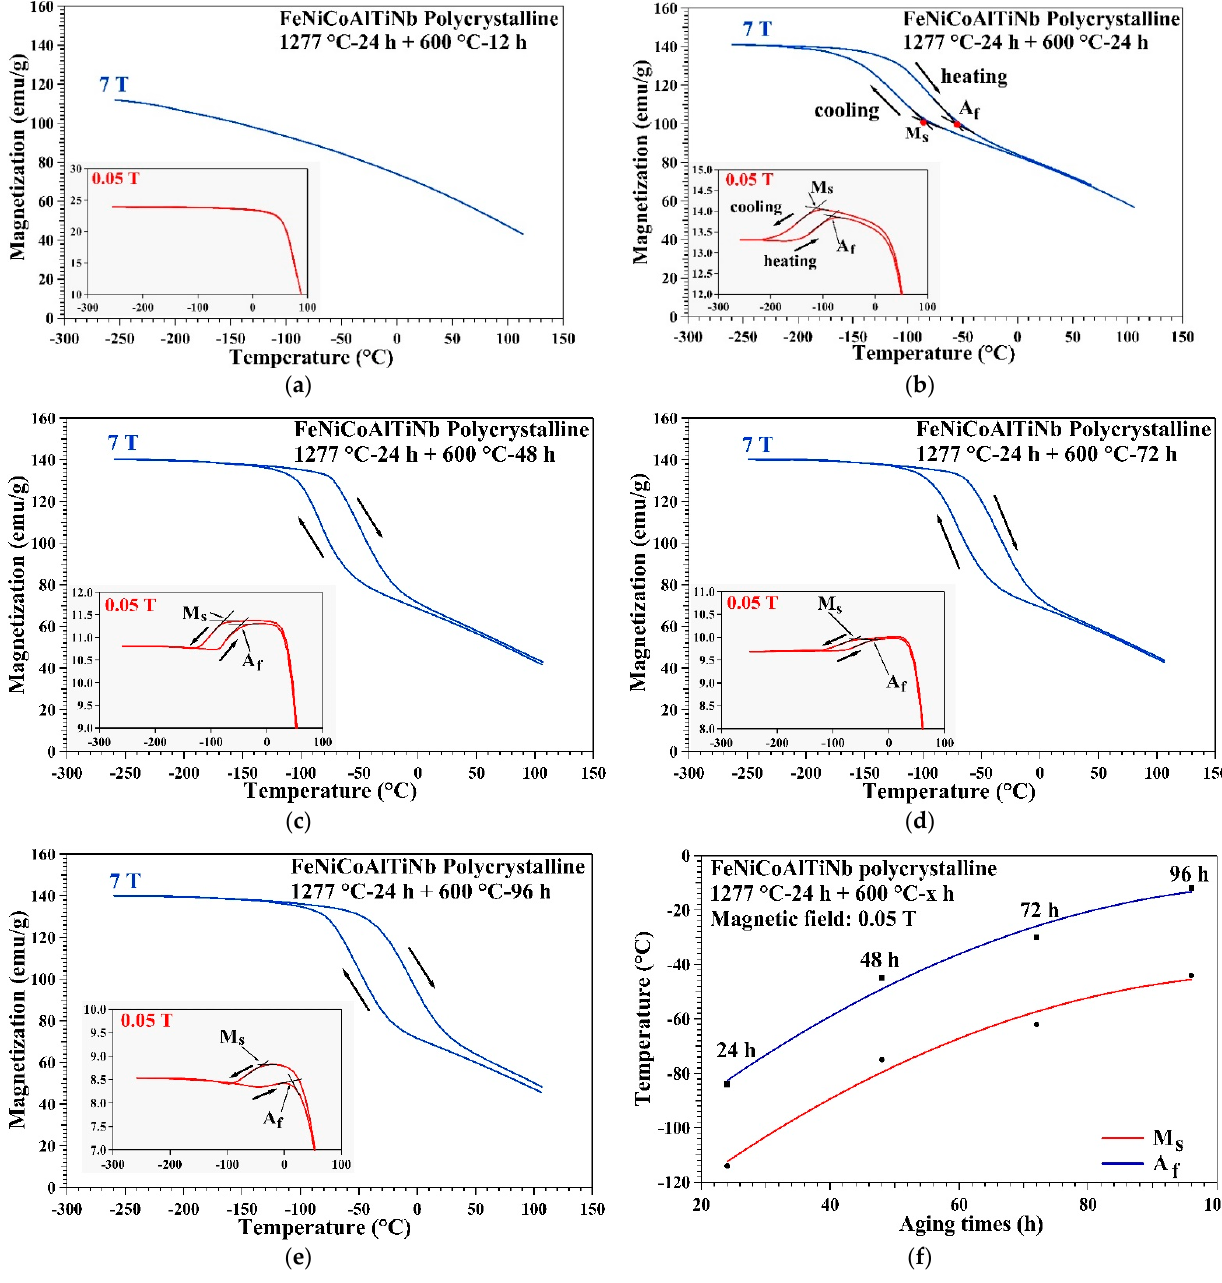
Figure 5. Thermo-magnetization curves of FeNiCoAlTiNb alloys under different aging conditions in magnetic fields of 0.05 and 7 T: ( a ) 1277 °C—24 h + 600 °C—12 h, ( b ) 1277 °C—24 h + 600 °C—24 h, ( c ) 1277 °C—24 h + 600 °C—48 h, ( d ) 1277 °C—24 h + 600 °C—72 h, ( e ) 1277 °C—24 h + 600 °C—96 h, and ( f ) the relationship between the transformation temperature and aging time. Table 3. Martensitic transformation temperatures and temperature hysteresis in aged FeNiCoAlTiNb samples under 0.05 Tesla and 7 Tesla.